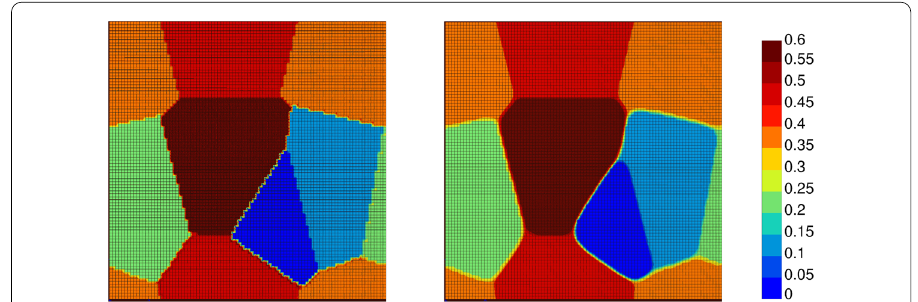
Fig. 2 Initial orientation distribution generated with Neper (left) and the orientation distribution after initial simulations with the orientation phase-field model (right). The orientation is given in radians. Because the orientation behaves as a phase-field, the grain boundaries in the coupled model are not restricted to follow the finite element grid and so there is no need to adapt the mesh to the morphology of the microstructure